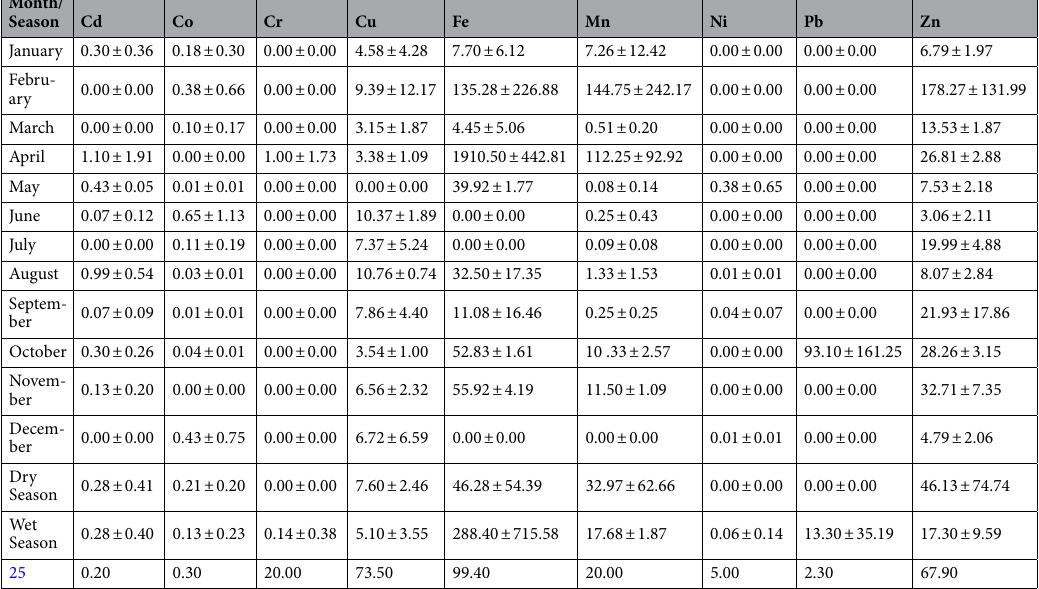
Table 3. Concentration of Heavy Metals (mg/kg) in I. aquatic in Agodi Reservoir. Source: Field Survey (The values in the bottom row are threshold values obtained from regulatory standards according to WHO 25 ).